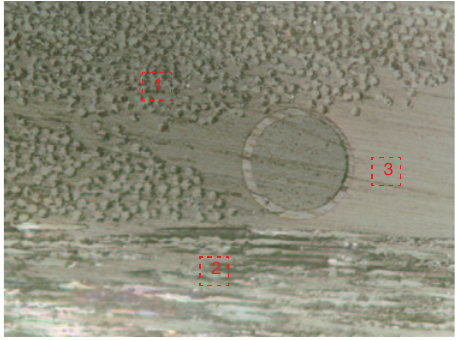
Figure 8: Microscopic image of the cross-section of an embedded optical fiber.